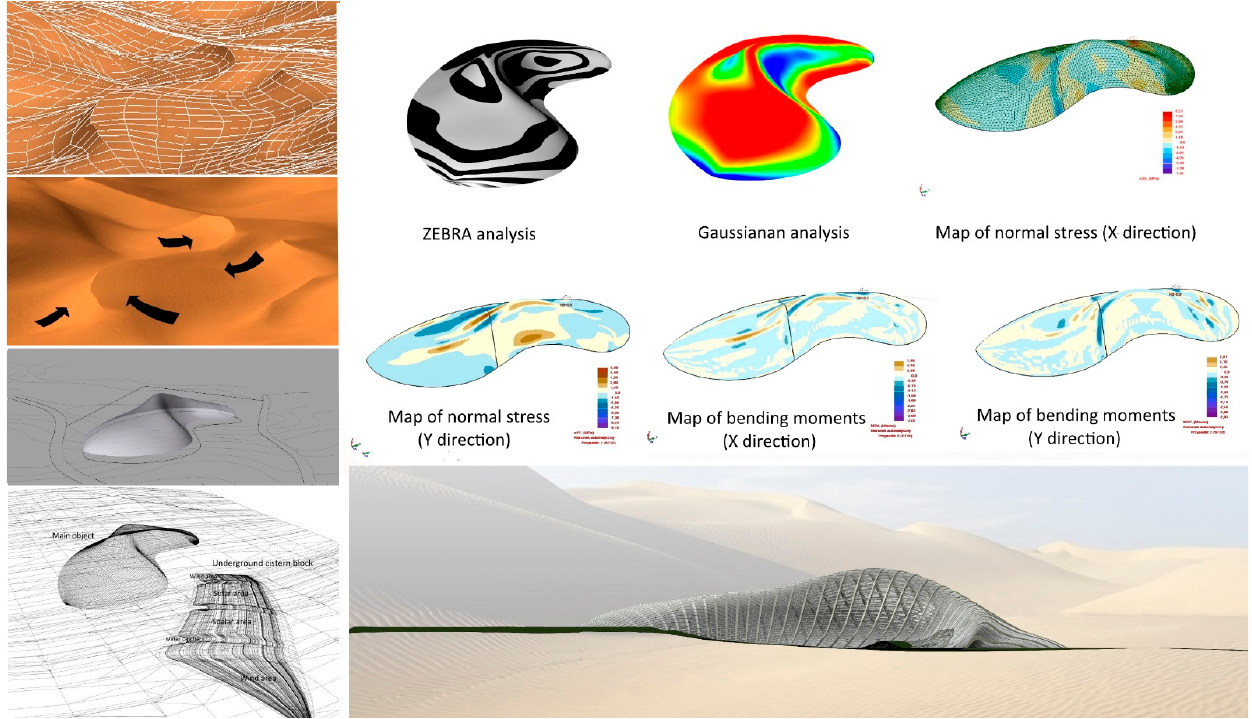
Figure 4. Anthropogenic oasis and Aqua Park with underground cisterns and a solar farm—design concept development and analytical stage: Geometric analysis and FEM analysis (Agnieszka Poli ń ska).